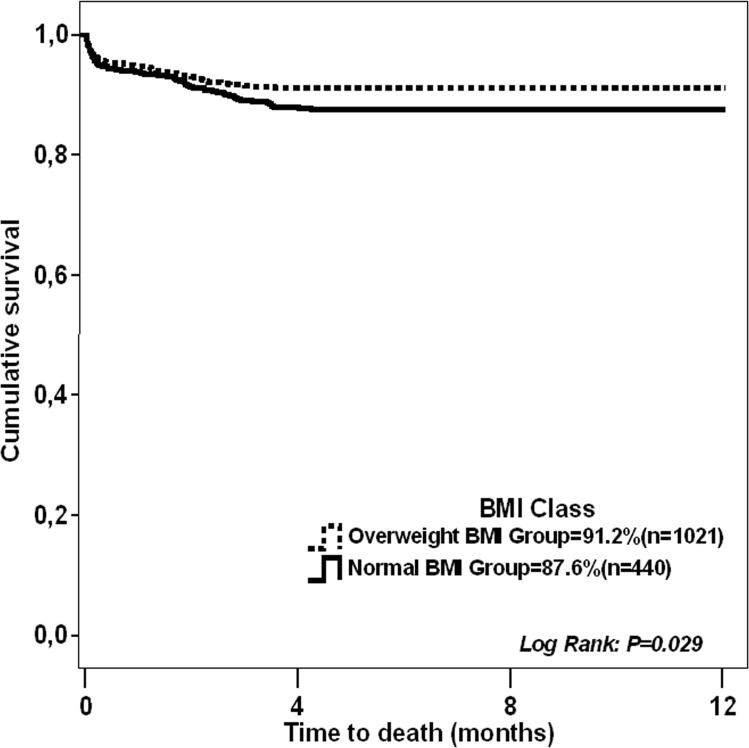
Kaplan-Meier survival curves comparing normal vs. overweight BMI groups.